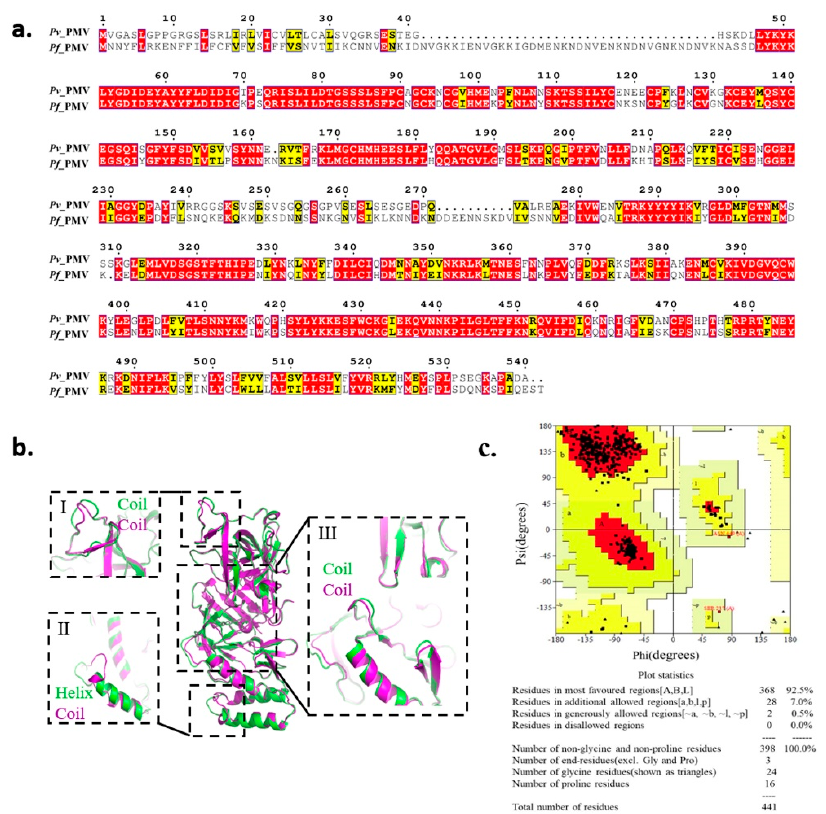
Figure 1. Homology modeling of Pf PMV 3D structure. ( a ) Sequence comparison of plasmepsin V in Plasmodium vivax and Plasmodium falciparum . ( b ) Superposition of homology 3D structure of Pf PMV (M09, in purple) and the crystal structure of Pv PMV (PDB: 4ZL4, in green). ( c ) The Ramachandran plot of model M09.